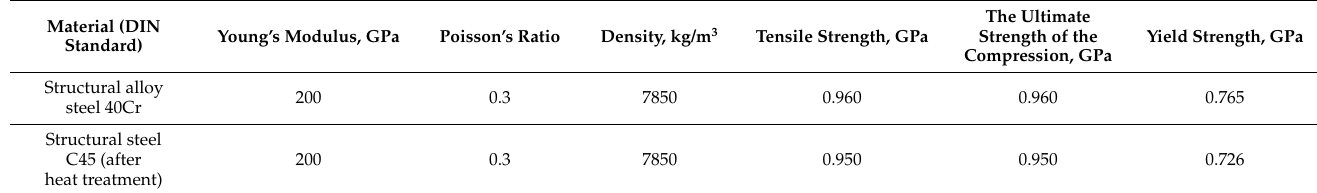
Table 2. Mechanical properties of the materials for the workpiece and fixture elements.